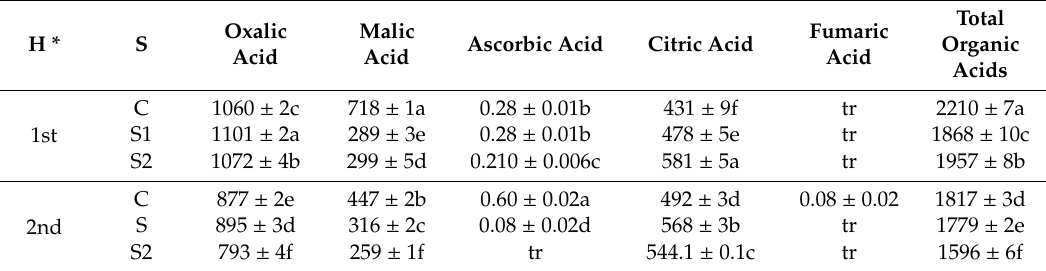
Table 5. Composition in organic acids (mg / 100 g fw) of Centaurea raphanina subsp. mixta leaves